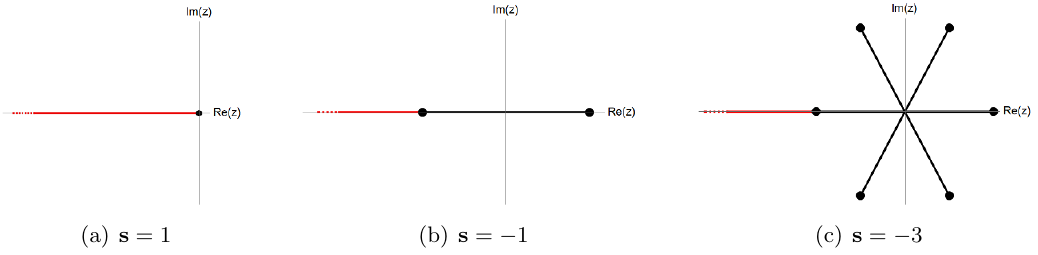
Figure 2 . Analytic structure of the deformed solution (A.11) in the complex plane of z for di(cid:11)erent values of s , with (cid:24) = (cid:22) (cid:24) = 0. The black lines correspond to the square root branch cuts connecting the singularities (A.18), while the red lines correspond to the logarithmic